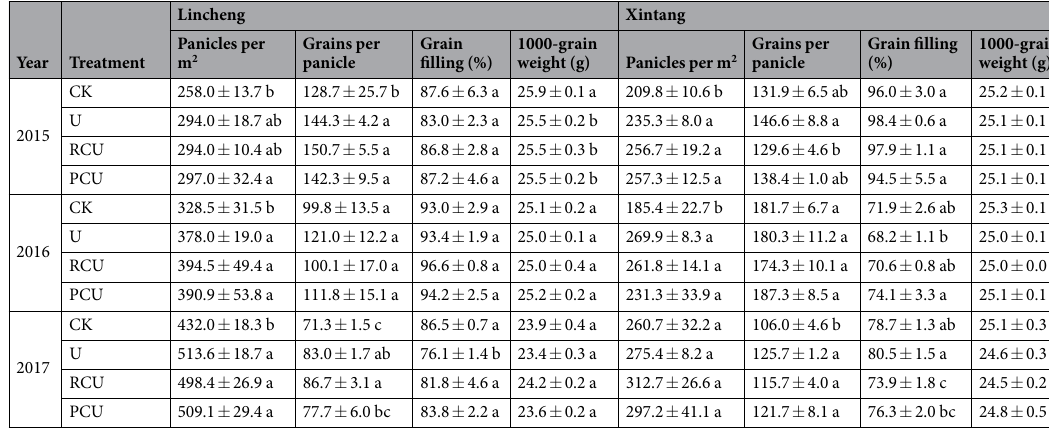
Table 5. Yield components of rice were affected by different treatments at the two experimental sites during the 2015 to 2017 rice seasons. The values are presented as the mean ± standard deviation (n = 3). Different letters in the same columns at the same site represent significant differences at the level of P < 0.05. CK, U, RCU and PCU represent no N application, conventional urea, resin-coated urea and polyurethane-coated urea,